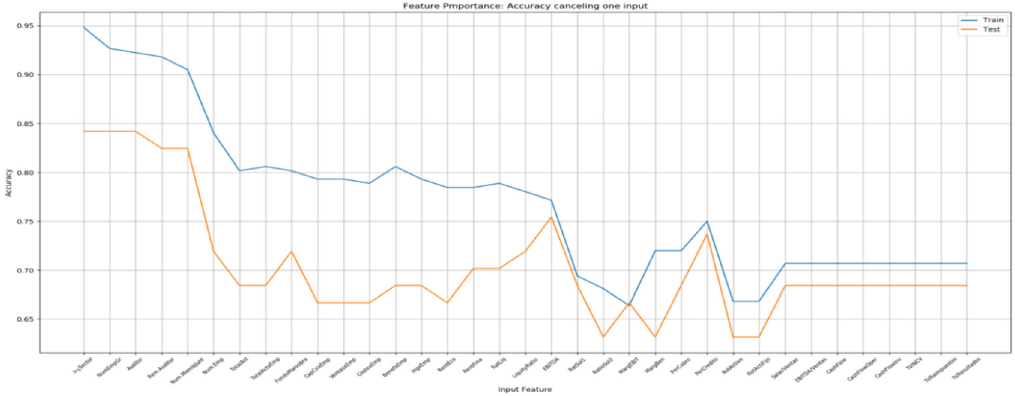
Figure 3. Results of the sensibility analysis. Table 5. Collinearity statistics.